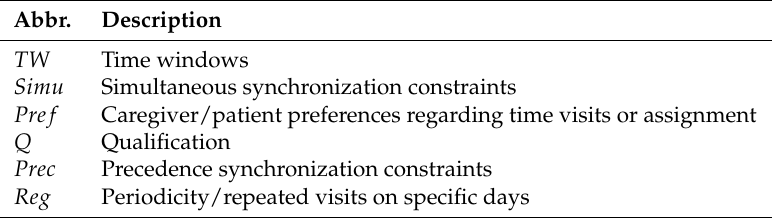
Table 3. Common families of constraints.